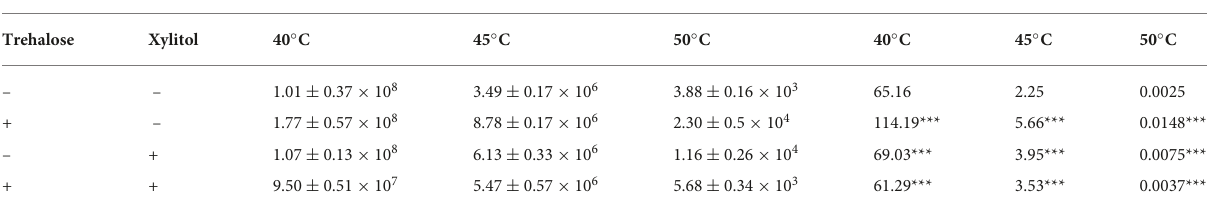
TABLE 2 Thermal protection evaluation. Additives Living cells